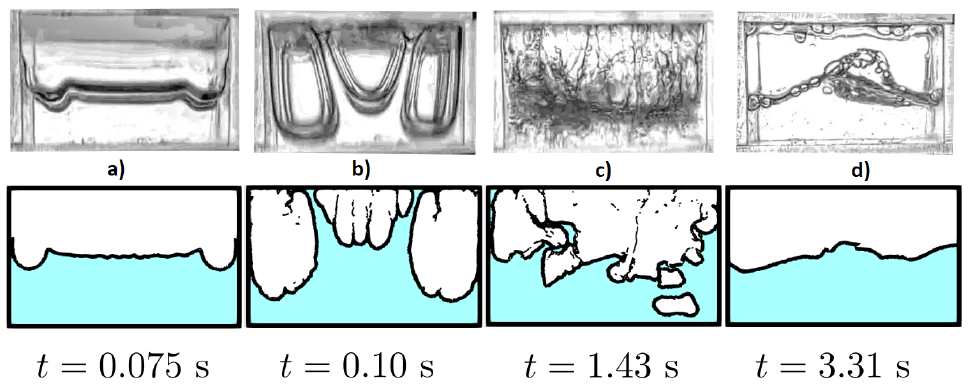
Figure 5. Experimental snapshots ( top ) of a vertical sloshing experiment with water at a 50% filling level and 10 g of maximum acceleration. Numerical counterparts ( bottom ) simulated the δ -SPH